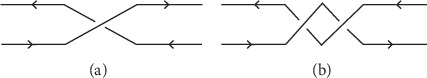
One crossing (a half-twist) and two crossings (a twist).